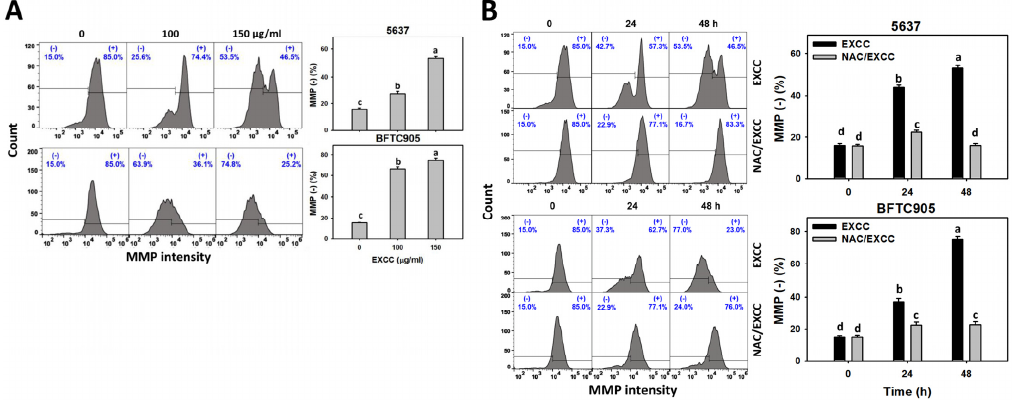
Figure 9. MMP change by EXCC. ( A ) MMP assay of EXCC. Two bladder cancer cell lines (5637 and BFTC905) were tested. Cells were treated with control (0.1% DMSO) and EXCC (100 and 150 μ g/mL) for 48 h. ( −) represents MMP ( − ) population. ( B ) MMP assay of NAC/EXCC. NAC/EXCC is the NAC pretreatment (10 mM, 1 h) coupled with EXCC posttreatment (150 μ g/mL, 24 and 48 h). Statistical lower-case letters were given to each treatment. Non-overlapping letters between different treatments indicate significant results ( p < 0.05). Data, means ± SD ( n = 3). For example (5637 cells in Figure 9B), the EXCC (black color) 0, 24, and 48 h indicating “d, b, and a” show significant results between each other because these letters were non-overlapping. In contrast, EXCC 0 (black color) and NAC/EXCC (gray color) 0 h indicating “d” show nonsignificant results because these letters overlap.